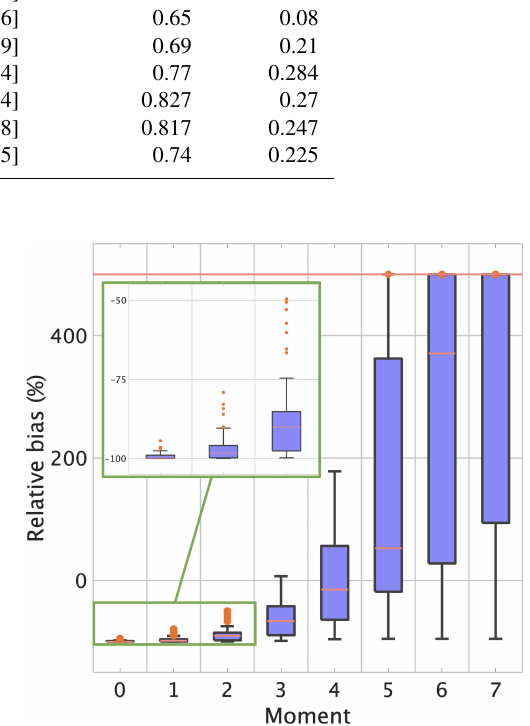
Figure 11. Box plots of relative bias (RB) as in Fig. 8e ex- cept between radar-derived moments and completed DSD moments (“truth”). The orange horizontal line on top indicates the upper inner fence.